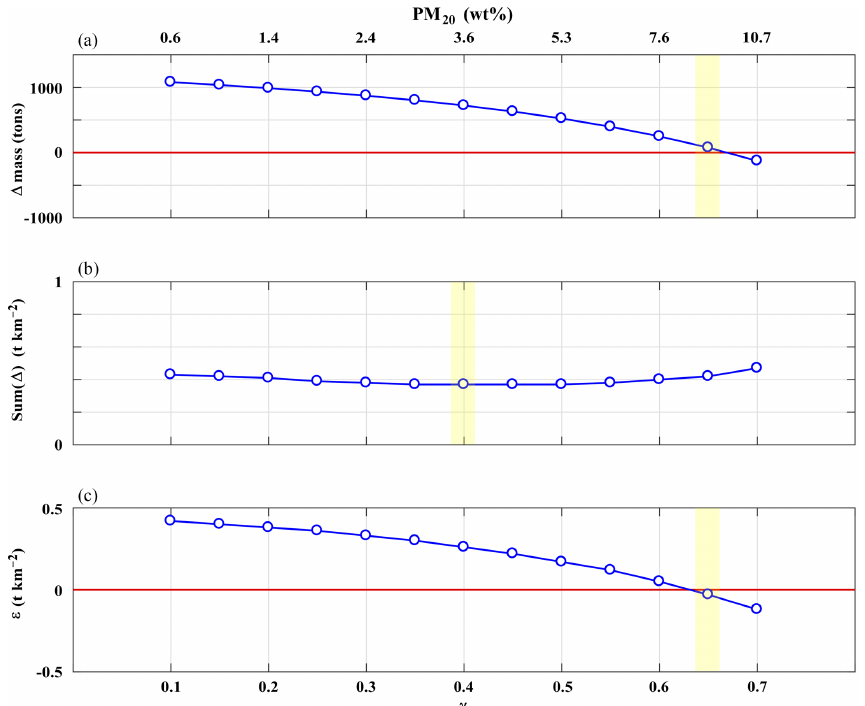
Figure 9. Quantitative analysis of the airborne ash mass measured from SEVIRI and computed by FALL3D to invert the PM 20 fraction to use within the Whole TGSD for best reproducing the SEVIRI retrievals. The upper part compares the whole airborne ash masses for the entire eruption, whereas the middle part gives the difference of the absolute average difference of mass per unit area. The lower part quantifies the difference in terms of mass per unit area (details in Sect.